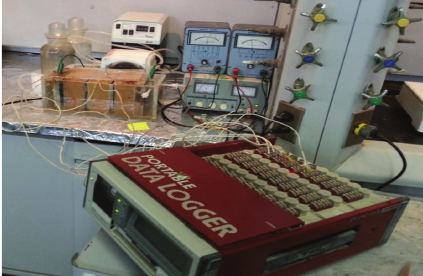
Figure 1: Coupled electrokinetics-adsorption experimental